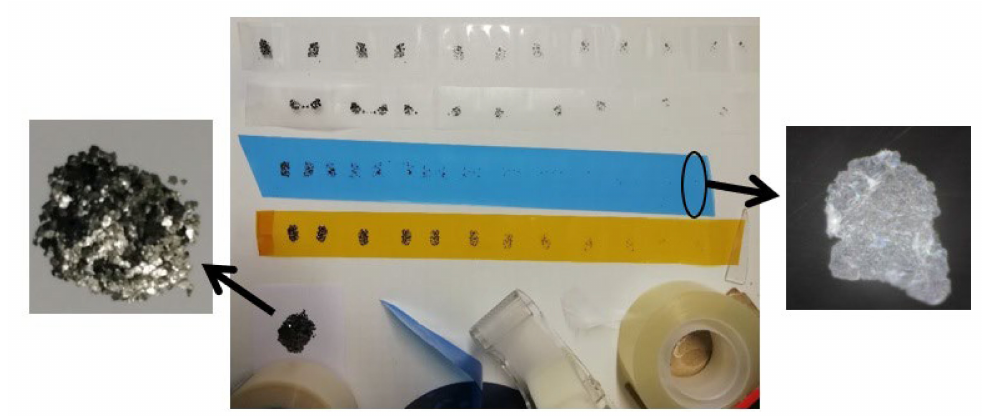
Figure 4. Natural graphite flakes’ mechanical (physical) exfoliation to graphene many-layers by adhesive tapes (picture and microscope image are taken in Universidad del Pais Vasco- Euskal Herriko Unibertsitatea—UPV/EHU laboratories, Bilbao,